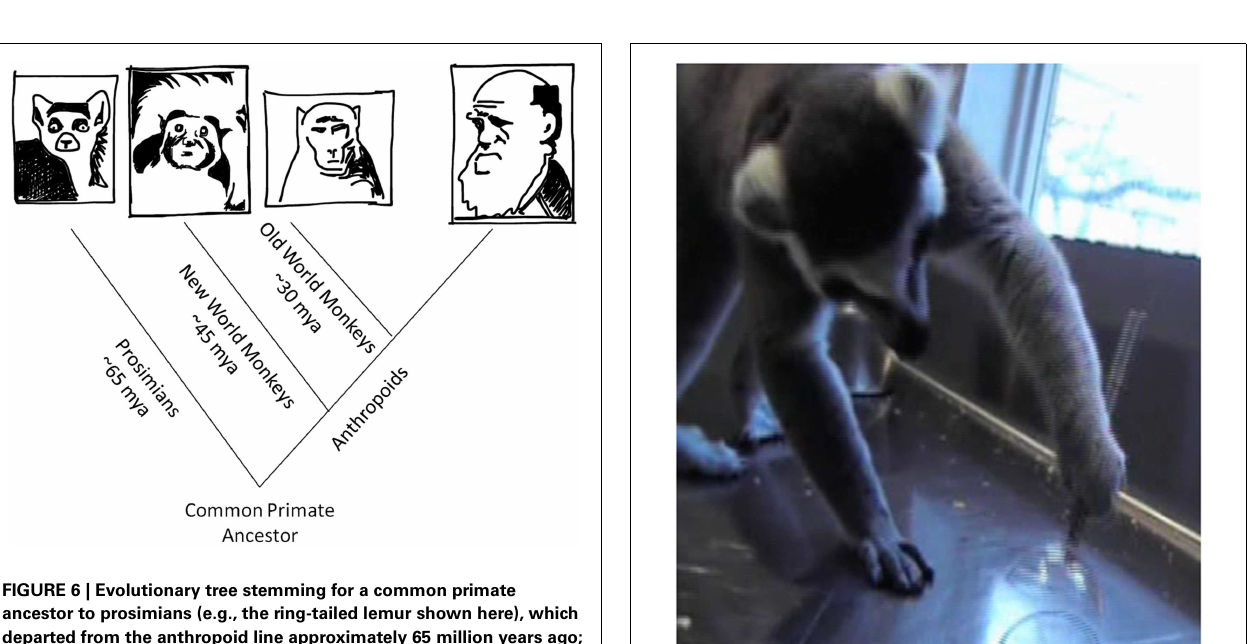
FIGURE 5 |A cotton-top tamarin performing the cub extraction task ofWeiss et al. (2007) . In (A) , the monkey grasps an upright cup’s stem using a canonical thumb-up posture. In (B) , the same monkey grasps the inverted cup’s stem using a non-canonical thumb-down posture. (Image fromWeiss et al., 2007.)